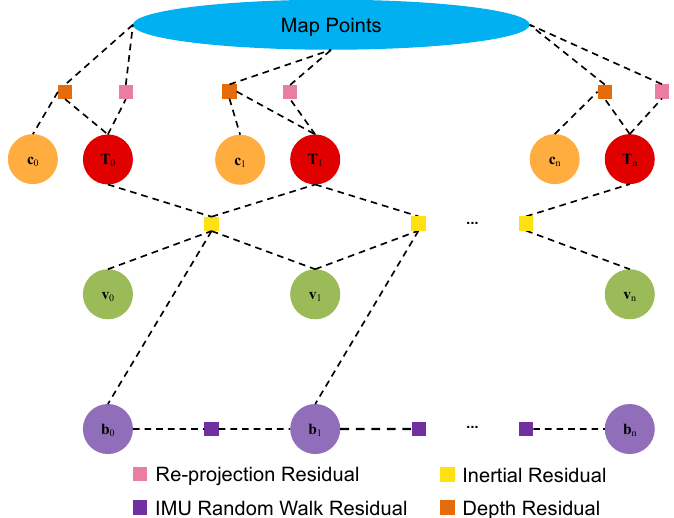
Figure 5. Factor graph of the system considering visual reprojection residuals, inertial residuals, IMU random walk residuals, and depth residuals on sparse points from the output of the depth completion network. T n : pose states, v n : velocity states, b n : IMU bias states, c n : depth